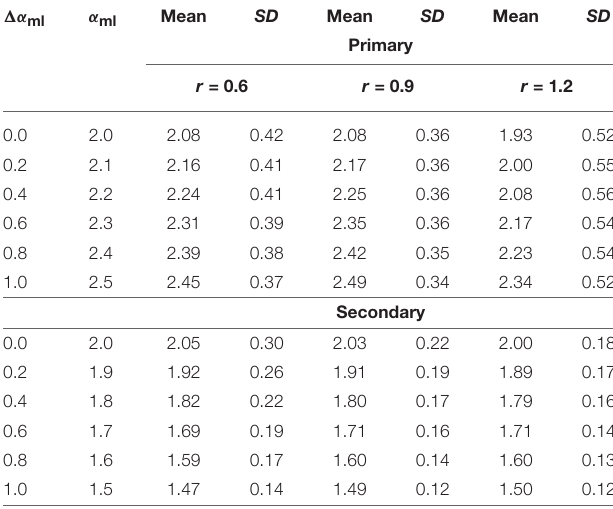
TABLE 4 | As in Table 3 , but splitting the result according to the evolutionary phase of the primary star.